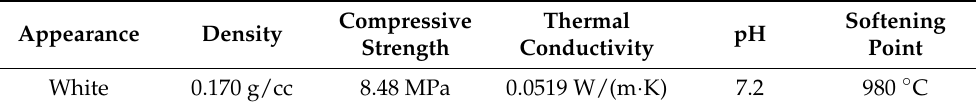
Table 2. The technical characteristics of hollow glass microspheres.